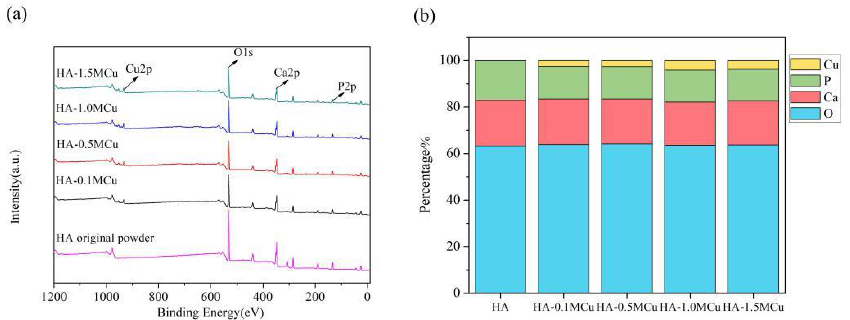
Figure 6. XPS patterns of Cu-doped HA macrobeads after sintering ( a ) and atomic ratio of Ca, P, O and Cu ( b ).